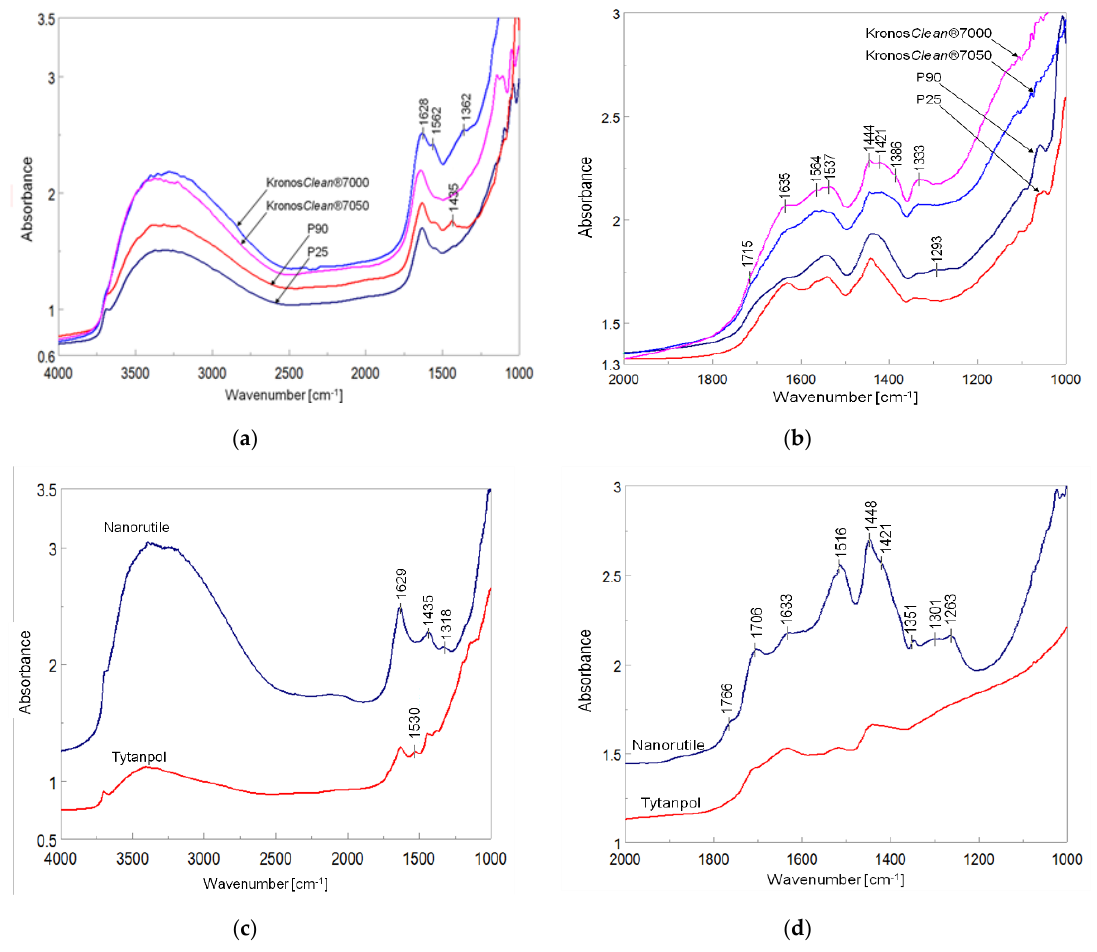
Figure 13. FTIR spectra of titania Kronos and Evonik samples as received ( a ) and after adsorption of acetaldehyde ( b ), rutile samples as original ( c ) and after adsorption of acetaldehyde ( d ). Table 4. Assignment of FTIR bands observed for commercial titania samples, as received.